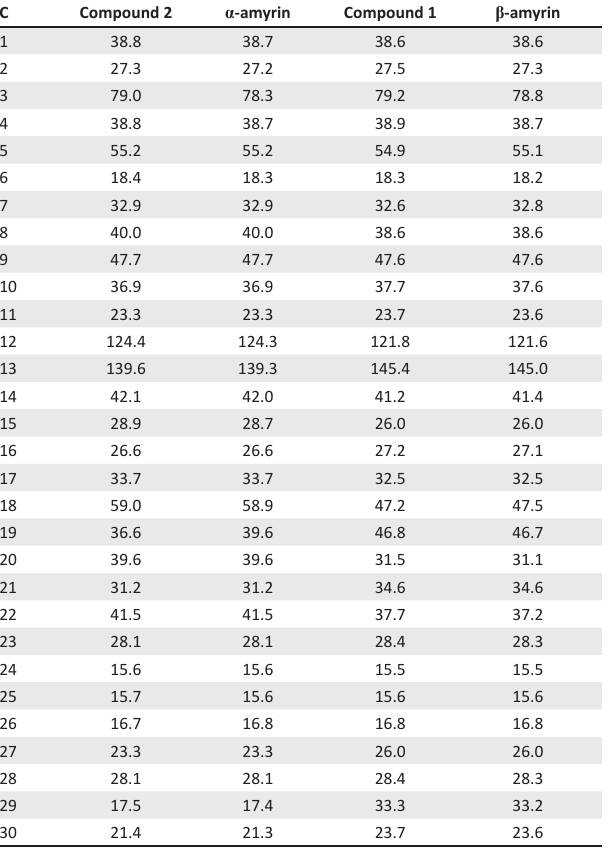
TABLE 2: 13 C NMR data of Compound 1 and 2 compared to 13 C NMR. C Compound 2